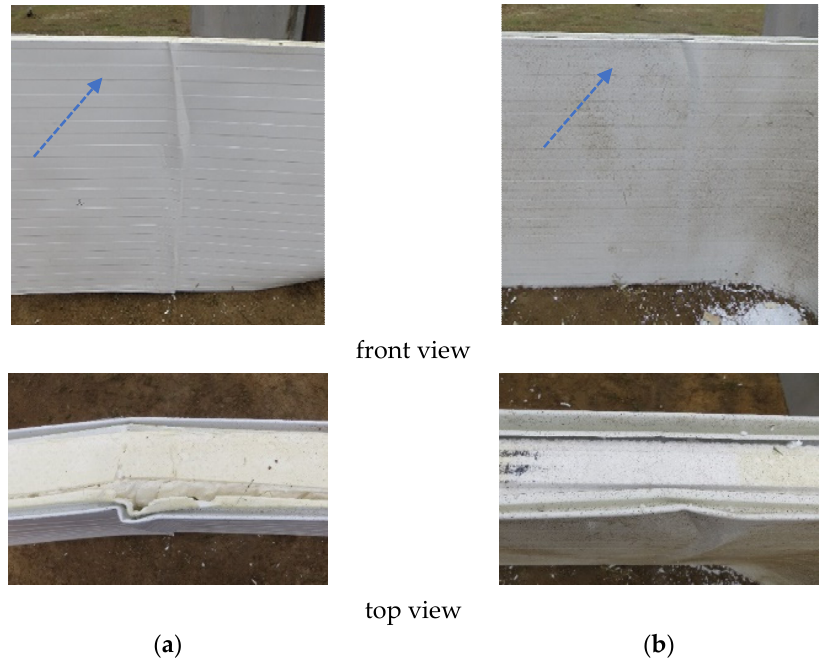
Figure 9. Wrinkling of the compressed facing (front and top view) for ( a ) the polyisocyanurate foam core and ( b ) the expanded polystyrene core.